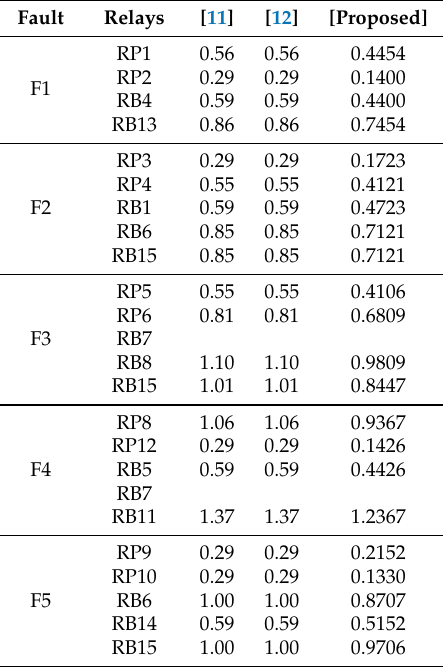
Table 10. Operation times for